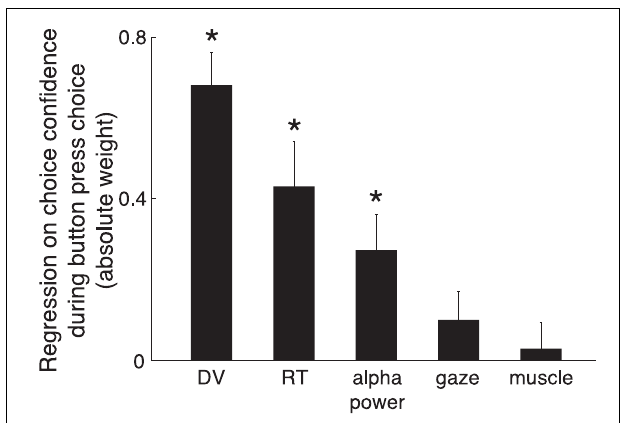
FIGURE 10 | The prediction of subjects’ confidence from the individual factors. Linear model (Equation 3) in which the individual factors (Section 2) are regressed on the choice confidence, during all button press choices. To ensure generalizability, the linear model considered each subject as a random effect influence on each factor. The weights were normalized (Section 2) so that a comparison of the weight magnitudes is fair. The error bar denote the SEM of each weight. For the purpose of visual comparison, the figure shows the absolute values of the weights. The text gives the actual values. * p < 0 . 01